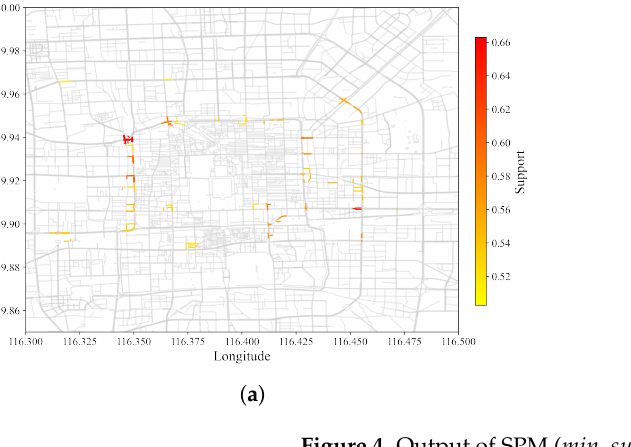
Figure 4. Output of SPM ( min _ sup = 0.5) against Beijing road map. ( a ) Without constraint ( b ) With constraint. Color changes from yellow to red as support increases. Higher support suggests more vehicles trajectories overlapping at the particular road segment.